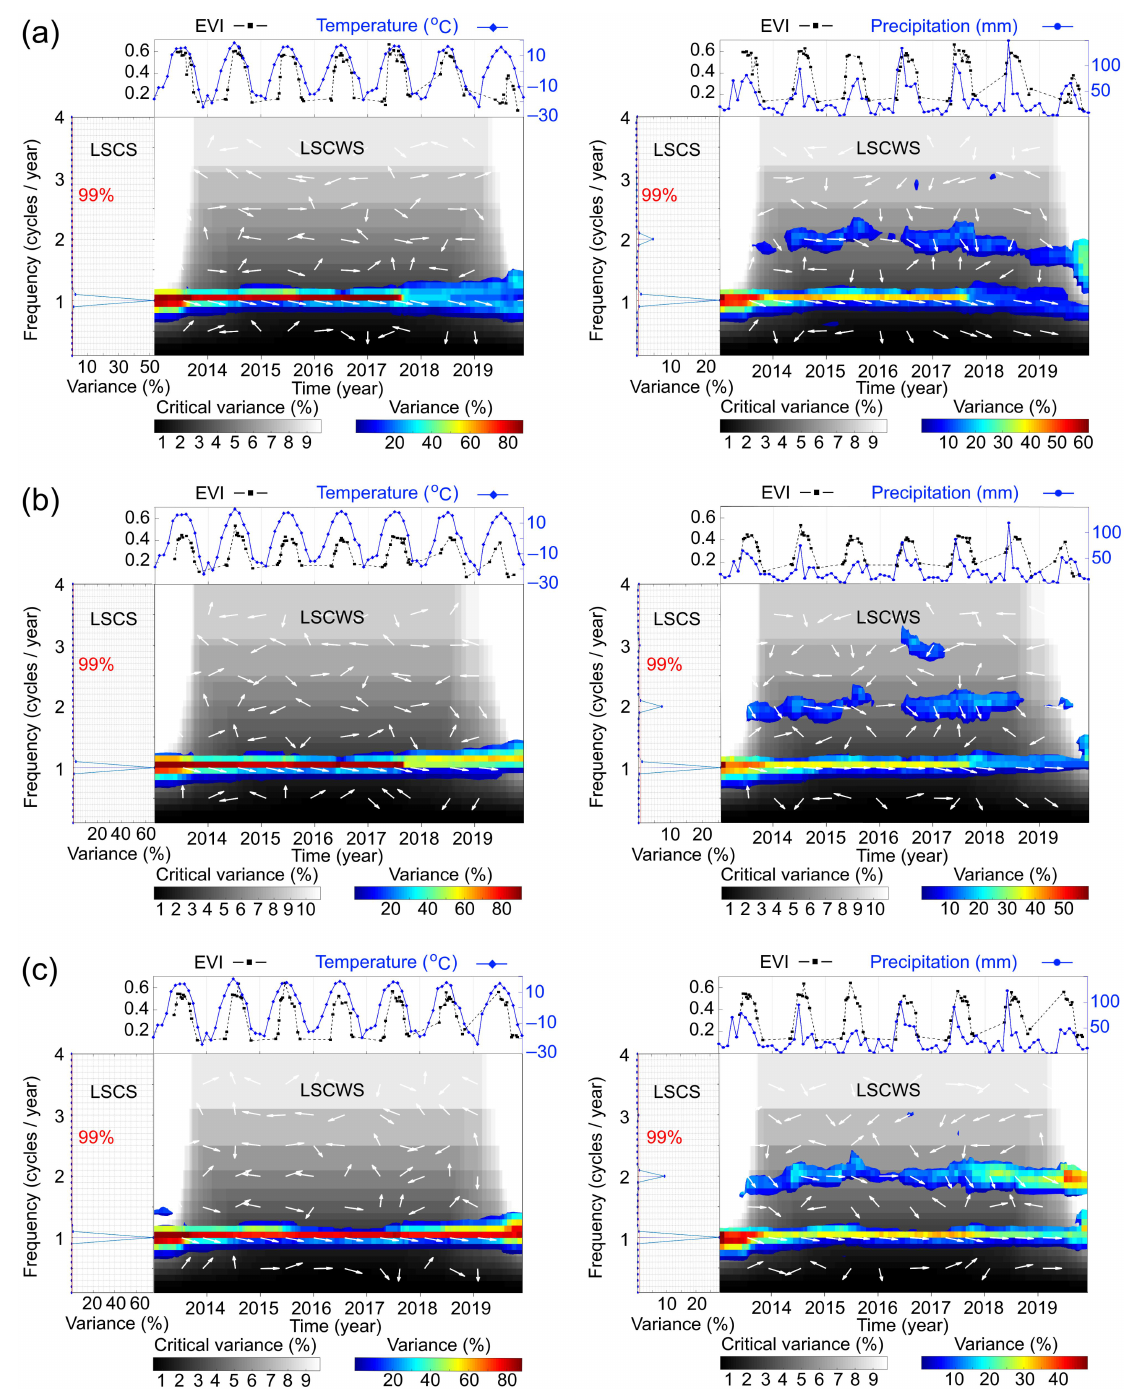
Figure 10. The coherency analyses between EVI and weather time series. Panels ( a – c ) show the results of time series corresponding to pixels A, B, and C shown in Figure 7, respectively. Temperature and precipitation are expressed in degree Celsius and millimeters, respectively. The stochastic surfaces in LSCWS at 99% confidence level are in gray, and the white arrows represent the phase differences following the trigonometric